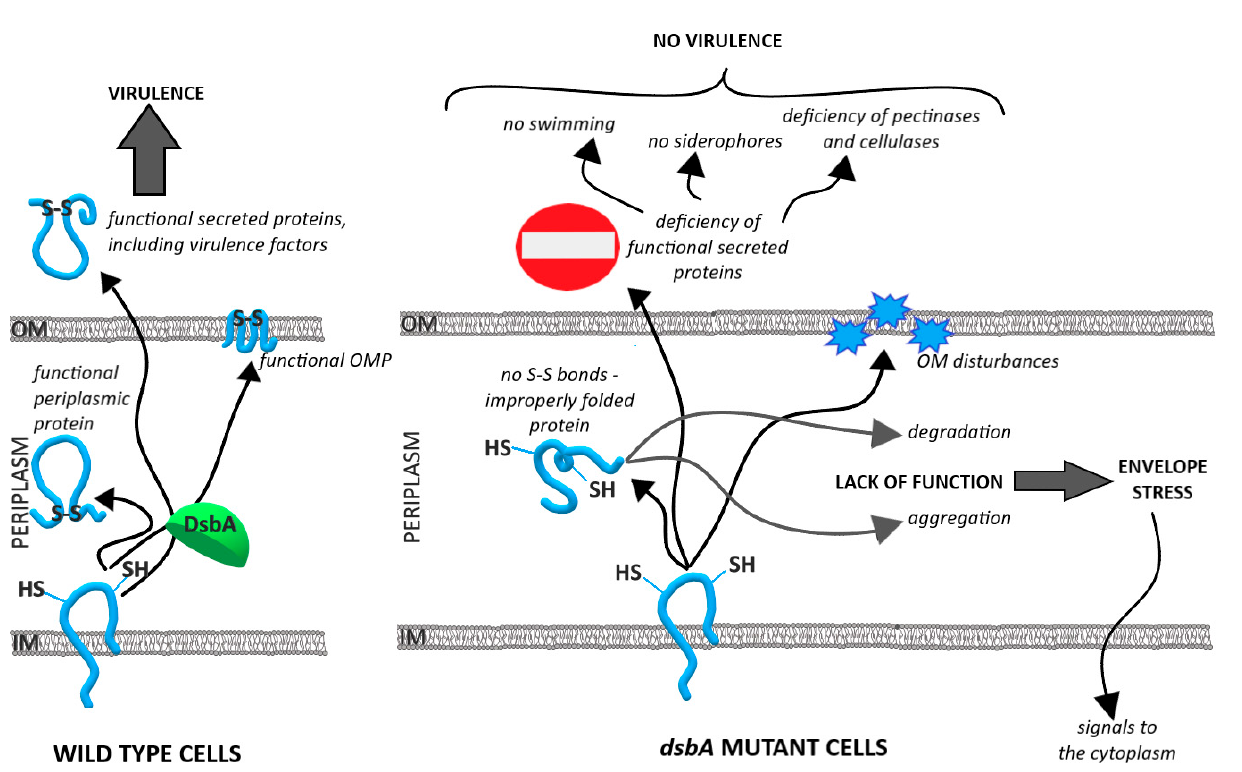
Figure 7. Model depicting the functioning of the D. solani cell in the presence and absence of the oxidoreductase DsbA. The properly functioning DsbA enzyme maintains the homeostasis of the cell envelope and ensures production of active virulence factors (left panel). The lack of DsbA disrupts the cell envelope homeostasis and causes an avirulent phenotype (right